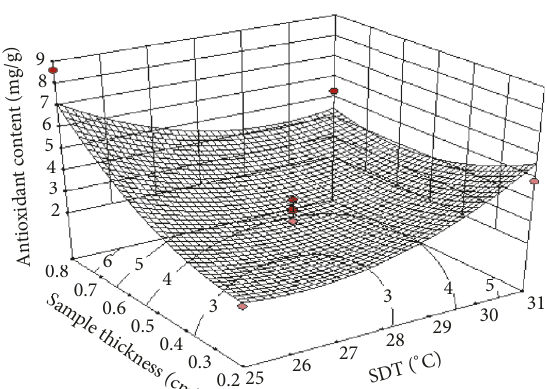
Figure 3: Effect of sample thickness and secondary drying temper- ature (SDT) on antioxidant